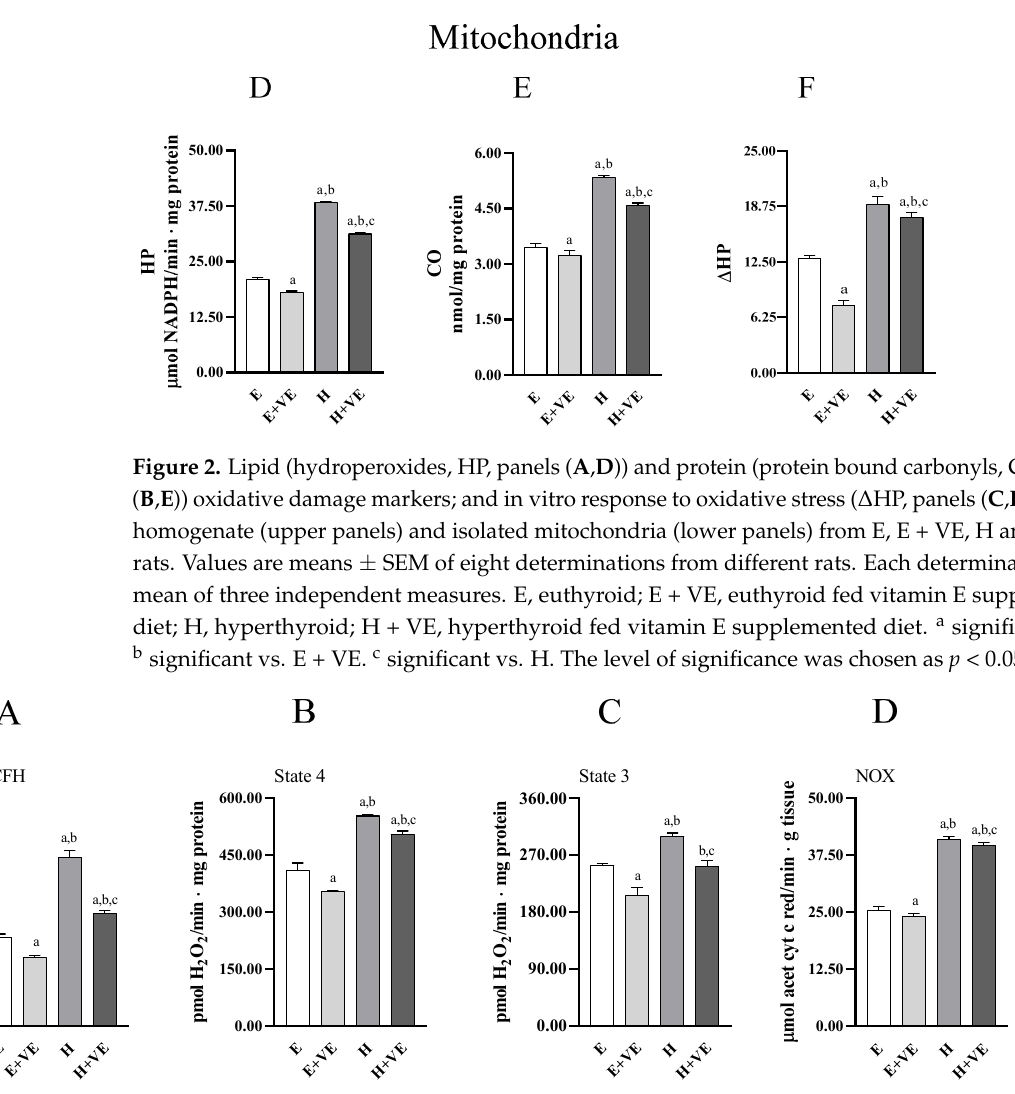
Figure 3. Total ROS content ( A ), mitochondrial H 2 O 2 release during state 4 ( B ) and state 3 ( C ) of respiration, and NADPH oxidase activity ( D ) in liver from E, E + VE, H and H + VE rats. Values are means ± SEM of eight determinations from different rats. Each determination is the mean of three independent measures. E, euthyroid; E + VE, euthyroid fed vitamin E supplemented diet; H, hyperthyroid; H + VE, hyperthyroid fed vitamin E supplemented diet. a significant vs. E. b significant vs. E + VE. c significant vs. H. The level of significance was chosen as p < 0.05. All measured parameters significantly increased in T 3 -treated rats. Vitamin E supplementation reduced total ROS content, mitochondrial ROS release and NOX activity regardless of thyroid status. However, in hyperthyroid animals all measured parameters remained higher than in euthyroid ones. These data suggest that the increase in oxidative damage in hyperthyroidism and the reduction seen after vitamin E supplementation may be related to the reduction in ROS production. 3.4. Antioxidant Enzymes Activity of Liver Homogenate To have information on the antioxidant enzymes system’s contribution to the changes in oxidative damage levels, we measured the activities of the enzymes glutathione peroxidase (Figure 4A), glutathione reductase (Figure 4B), catalase (Figure 4C), and superoxide dismutase (Figure 4D). All the antioxidant enzymes activities increased in hyperthyroid animals. At the same time, vitamin E supplementation reduced the activities of GPX, GR and SOD in euthyroid rats and of GPX, catalase and SOD in hyperthyroid rats. Figure 4. Antioxidant enzyme activities. GPX ( A ), GR ( B ) catalase ( C ), and SOD activity ( D ) in liver from E, E + VE, H and H + VE rats. Values are means ± SEM of eight determinations from different